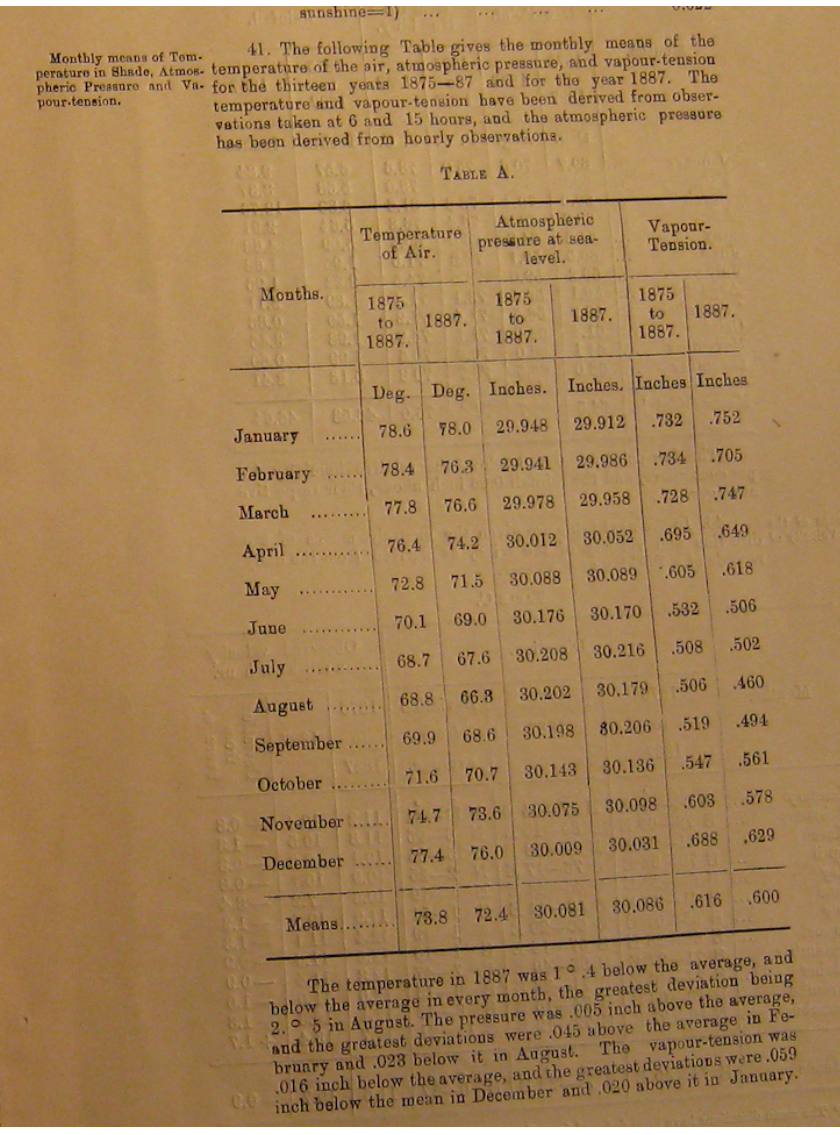
Figure 5. From the first annual summary imaged by NOAA NCEI, a summary table in the front matter compares the period 1875 to 1887, implying continuous measurements of air temperature over that period. Units are Fahrenheit, and the image misalignment is as